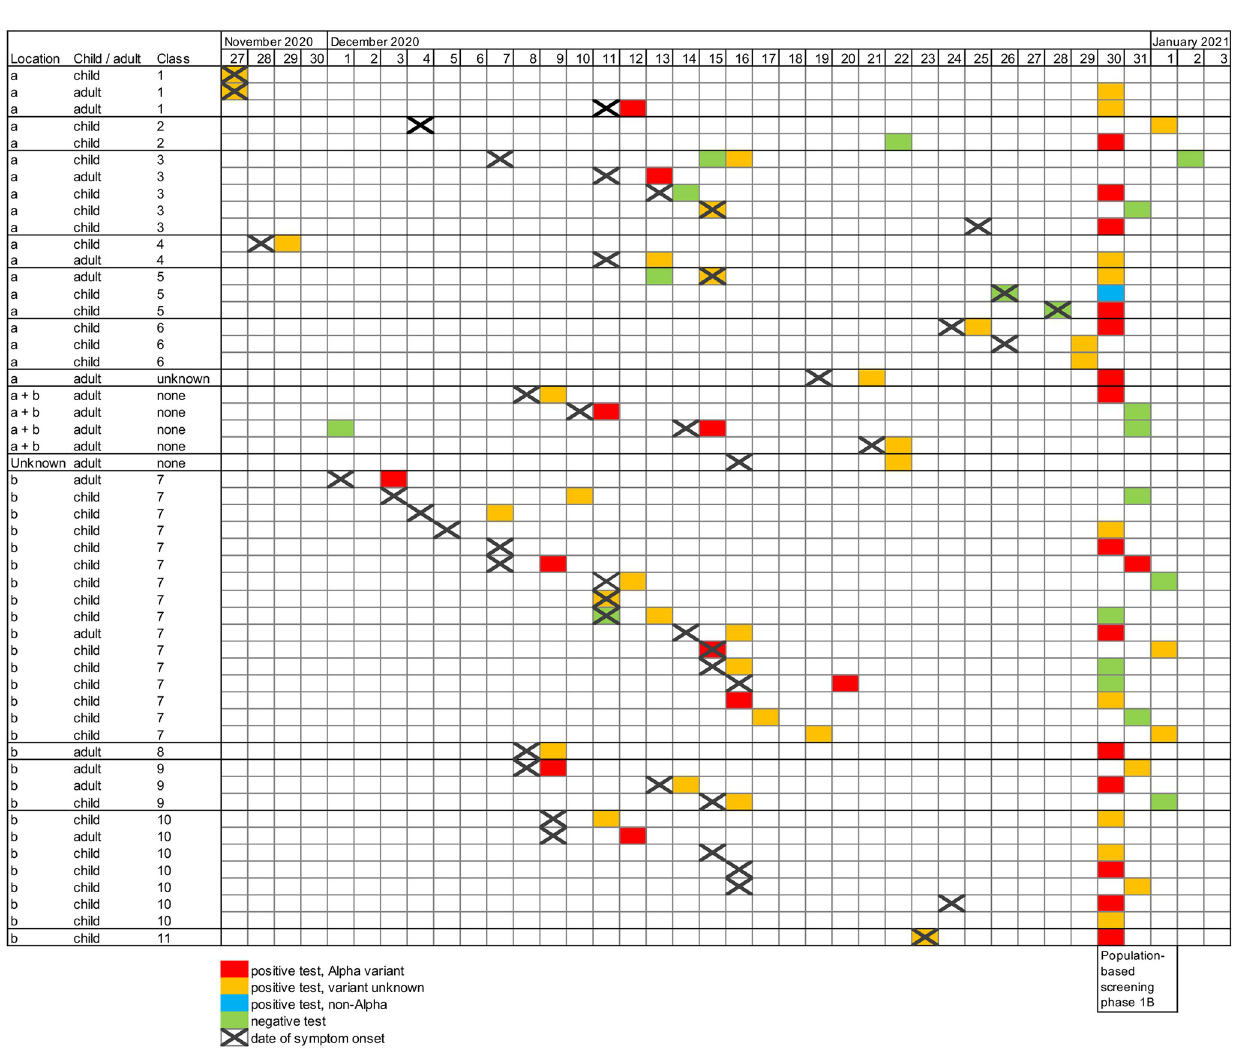
Fig 1. Timeline of cases at School X by classroom and school location in Lansingerland. Each line represents one case with symptom onset (black diagonal cross) and sampling date with variant (coloured box). School children and staff of School X were voluntarily tested regardless of symptoms between December 30 th 2020 and January 1 st 2021 (phase 1A and